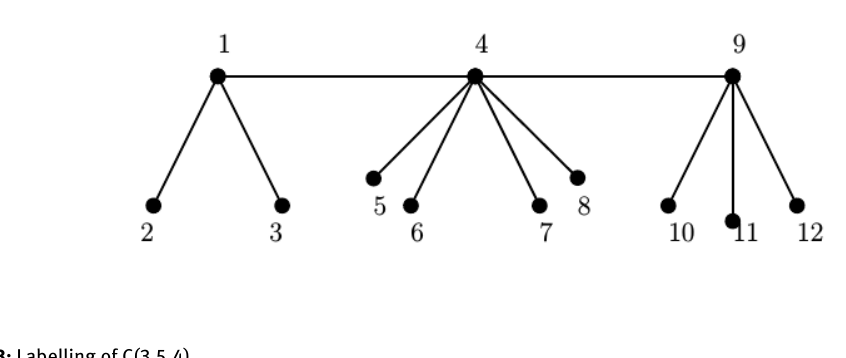
Figure 3: Labelling of